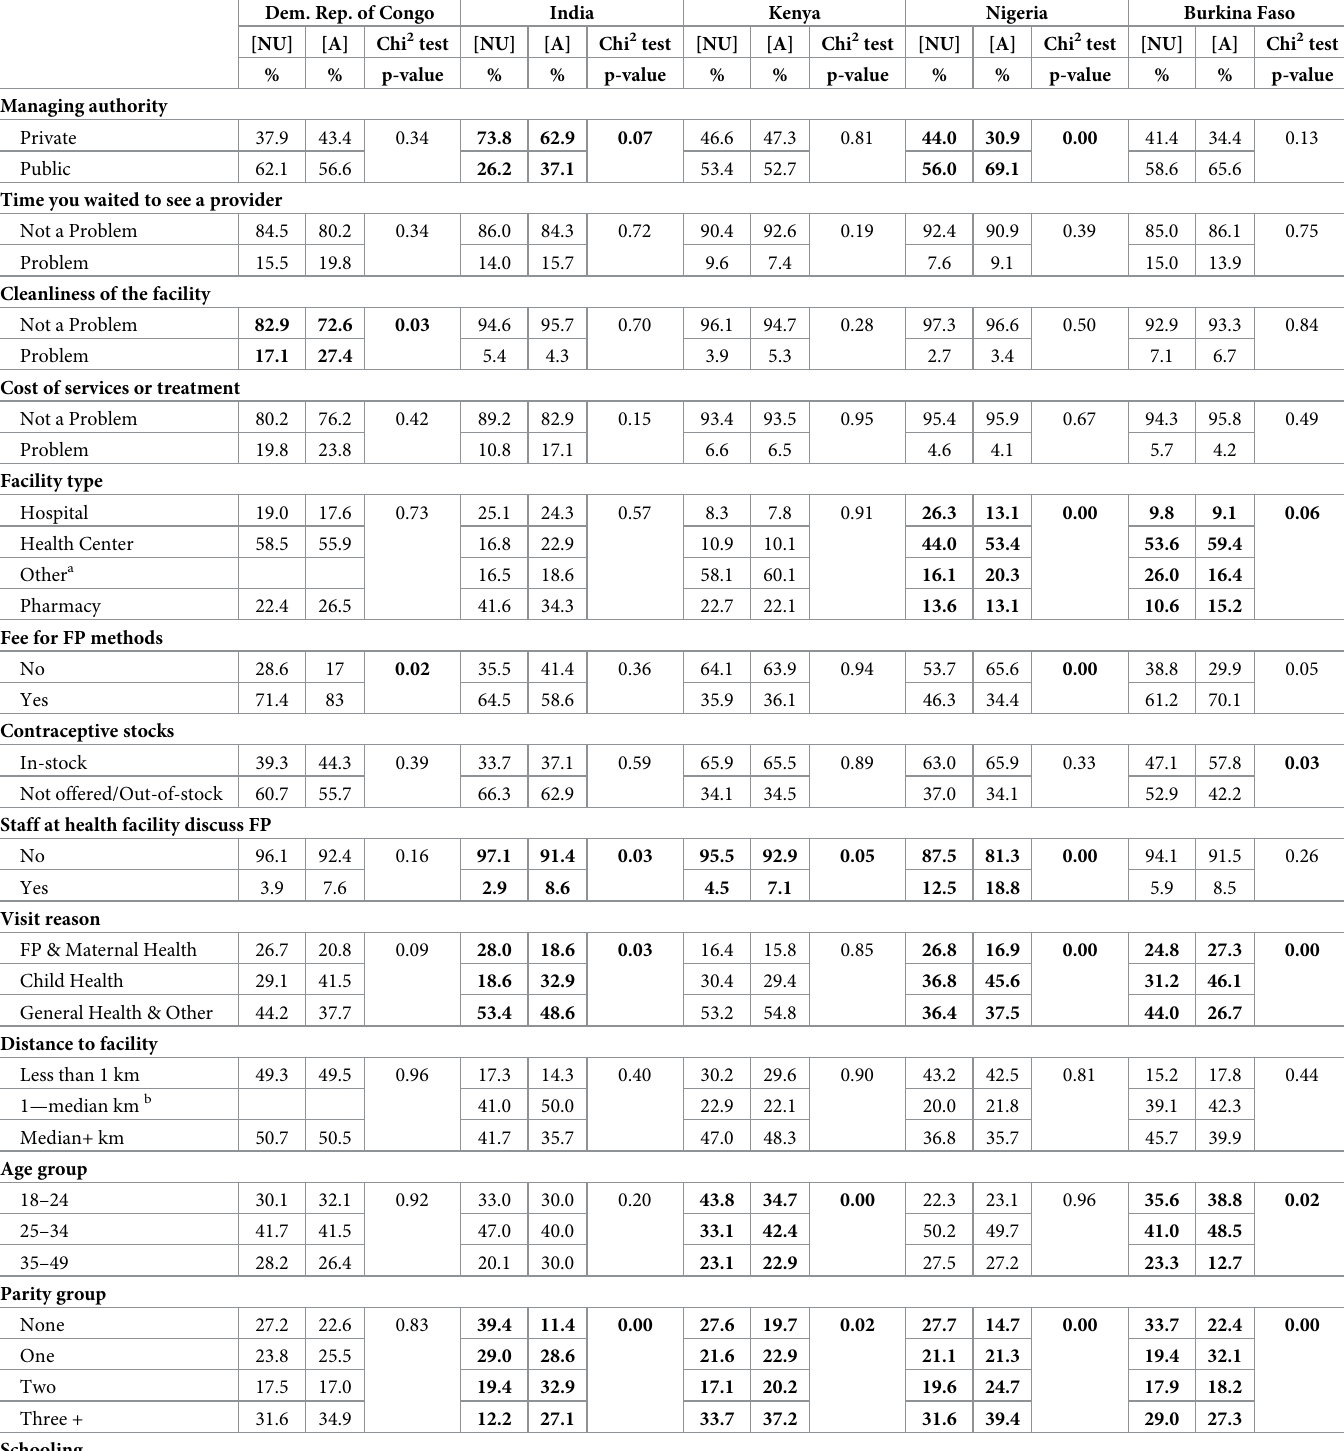
Table 2. Percent distribution of individual and service delivery point characteristics for continuing non-users and adopters at baseline in the Democratic Republic of Congo, India, Kenya, Nigeria, and Burkina Faso. Dem. Rep. of Congo India Kenya Nigeria Burkina